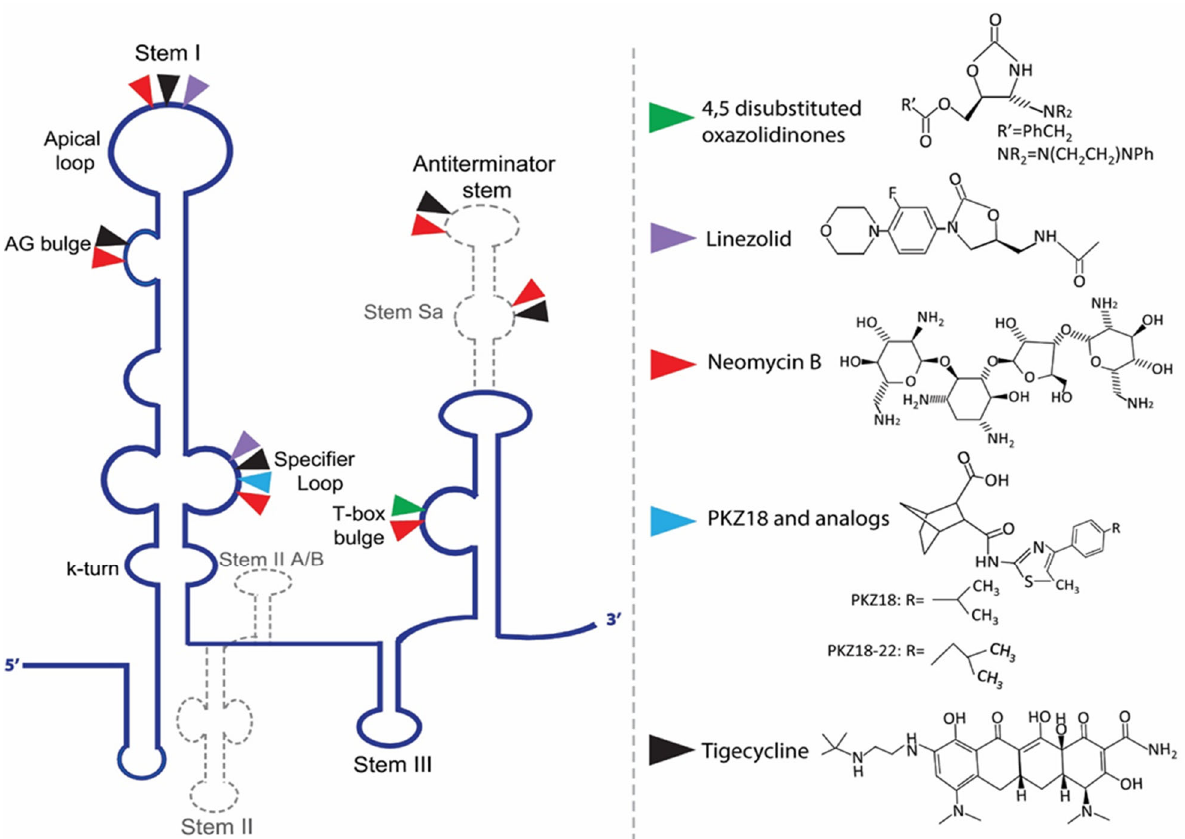
Figure 3. Illustration of the proposed model of antimicrobial compounds binding sites on the T ‐ box riboswitch ( left ). The arrows indicate the binding positions of the antimicrobial compounds that target the T ‐ box riboswitch. The stems that are not always present on the T ‐ boxes are illustrated with dashed lines. Each color of the arrows represents a different compound. The chemical structure of the antimicrobial compounds is also indicated ( right ).